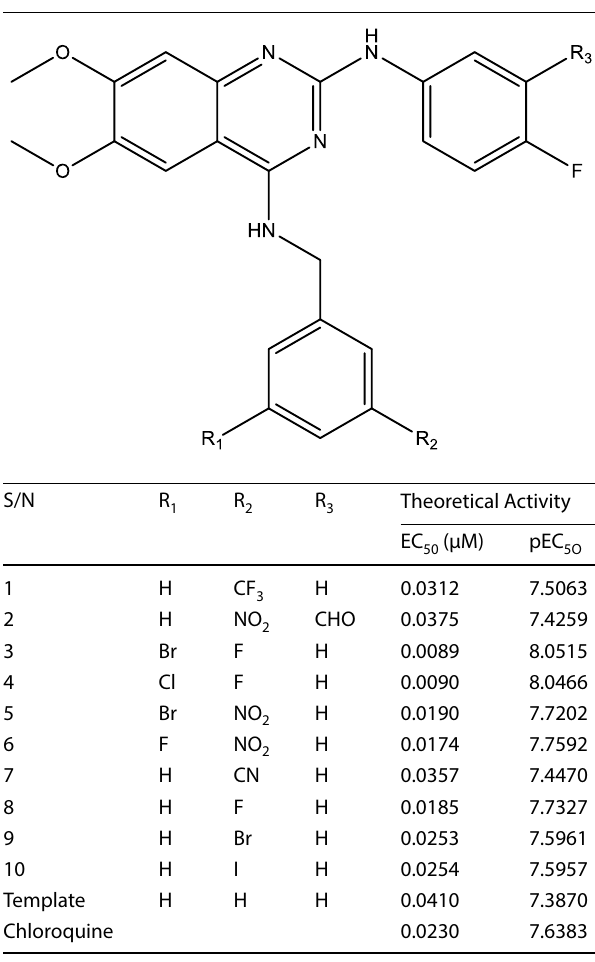
Table 6 Structures of the template, its designed derivatives, and their theoretical